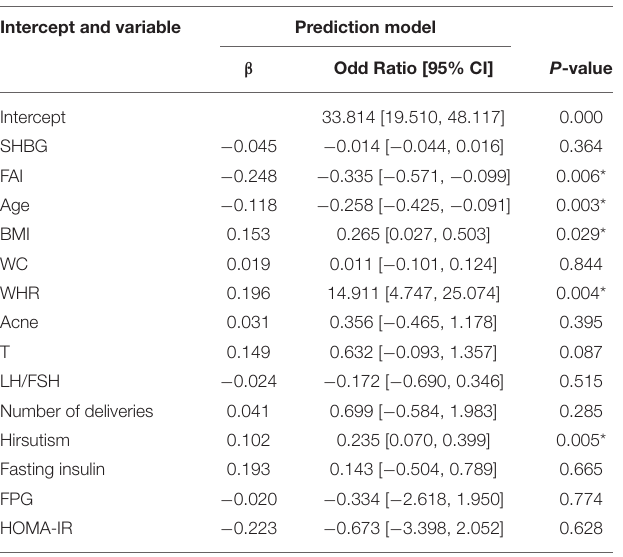
TABLE 4 | Linear regression analysis between SDS-SS and the clinical parameters of women with PCOS. Intercept and